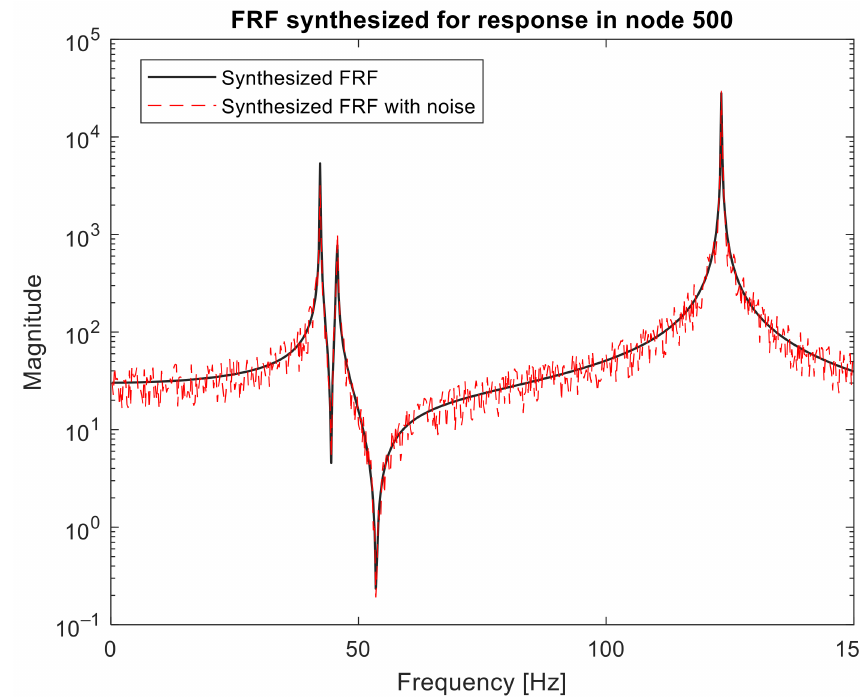
Figure 3. Example of synthesized FRF.